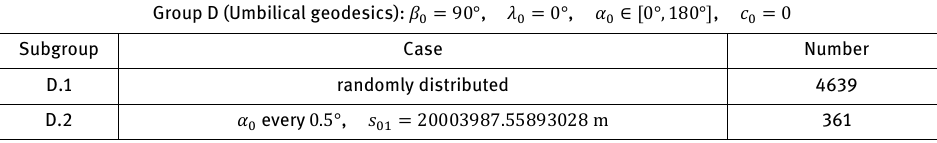
Group E: 𝛽𝛽 0 ∈ ( − 90°,90°) randomly